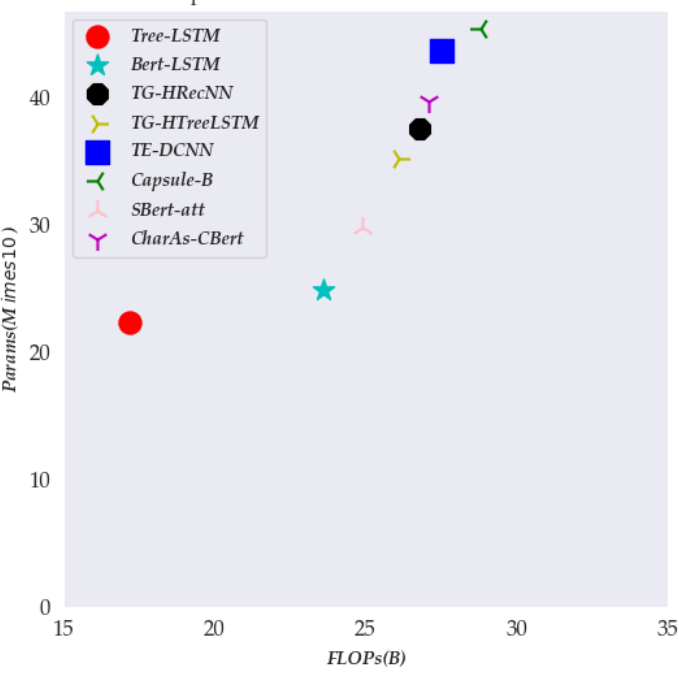
Figure 2. The performance of different sentence representation models. Params indicates the number of model parameters; FLOPs indicates floating-point